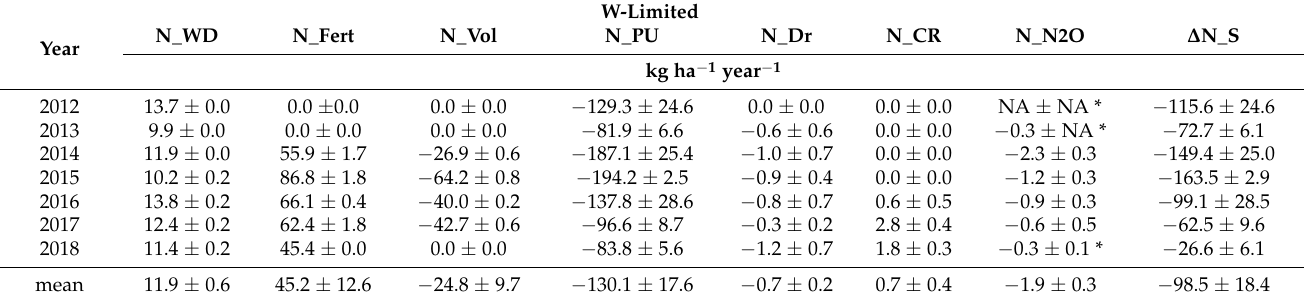
Table A5. Components of the lysimeter soil nitrogen balance—mean values and standard deviations, ± , in kg ha − 1 year − 1 — for Rollesbroich soil in Selhausen, the water-limited site (W-limited) between 2012 and 2018 with the wet deposition (N_WD), applied fertilizer (N_Fert), volatilization of the fertilizer nitrogen (N_Vol), plant nitrogen uptake (N_PU), nitrogen in drainage (N_Dr), nitrogen in capillary rise (N_CR), gaseous nitrous oxide nitrogen (N_N 2 O), and change in soil nitrogen storage ( ∆ N_S); negative values represent a loss of nitrogen for the system; column “mean” indicates the means of the annual values for the period 2012–2018 and the inter-annual variability is represented by the standard error of annual means. NA stands for Not